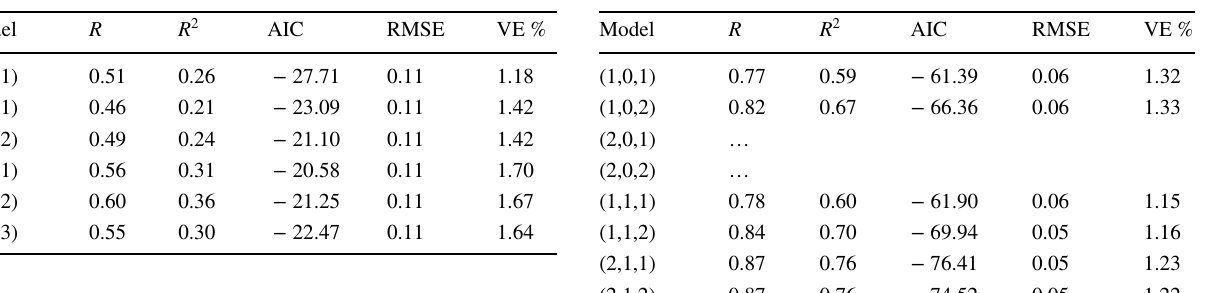
Table 6 The consequences of Ca 2+ group, order